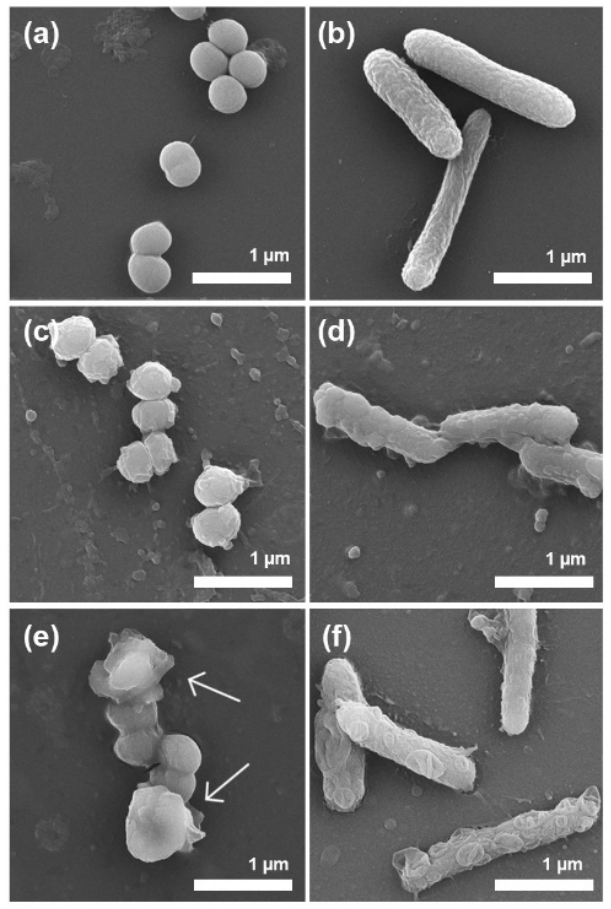
Figure 9. SEM images of untreated (natural) S. epidermidis ( a ) and E. coli ( b ), free OEO treated S. epidermidis ( c ) and E. coli ( d ), and OEO-loaded SMV treated S. epidermidis ( e ) and E. coli ( f ).